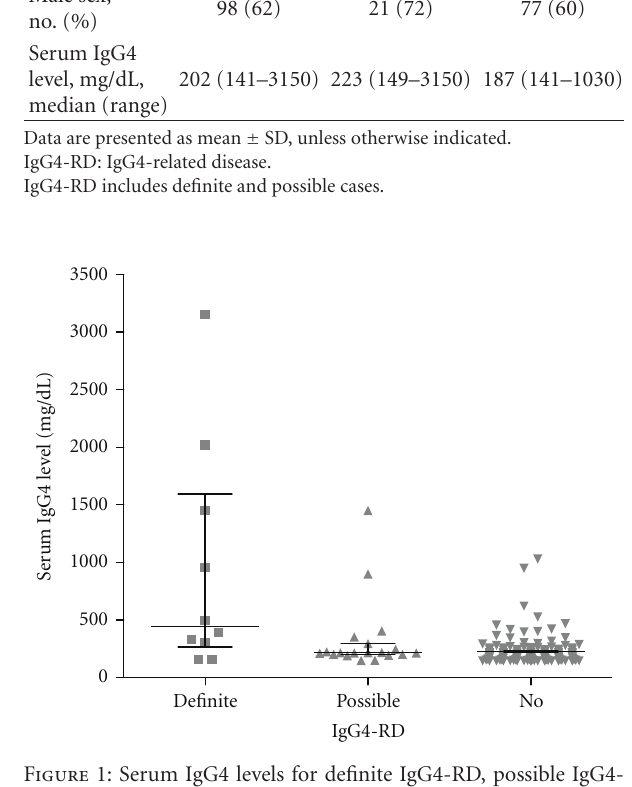
Figure 1: Serum IgG4 levels for definite IgG4-RD, possible IgG4- RD, and non-IgG4-RD subgroups. Median and interquartile range (25% to 75%) are